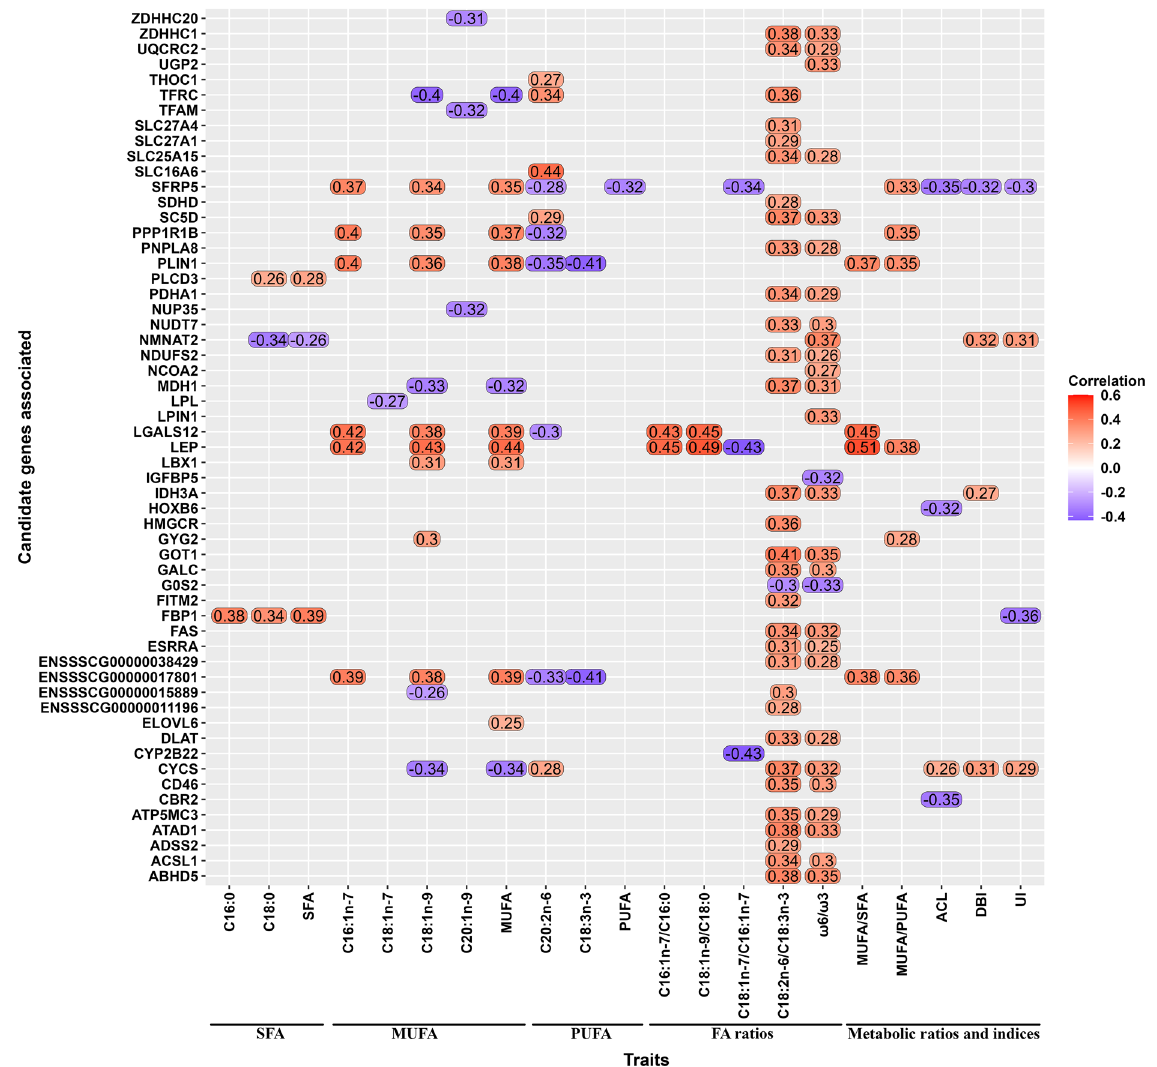
Figure 3. Heatmap of Pearson correlations of 21 representative traits with gene expression of 57 candidate genes related to FA profile traits in BC1_DU pigs. All these genes passed the correlation criteria according to a BH adjusted P -value < 0.05. The grouping of the FA profile traits is the same as that of the ELMSeq